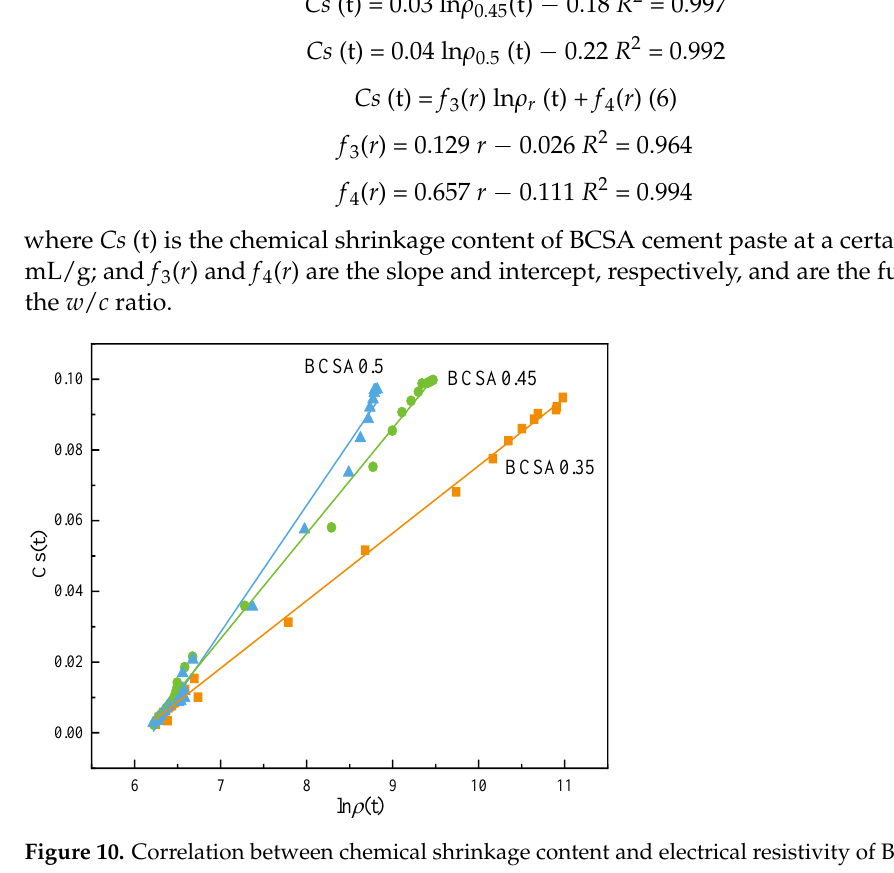
Figure 10. Correlation between chemical shrinkage content and electrical resistivity of BCSA pastes with various w / c ratios. with various w / c